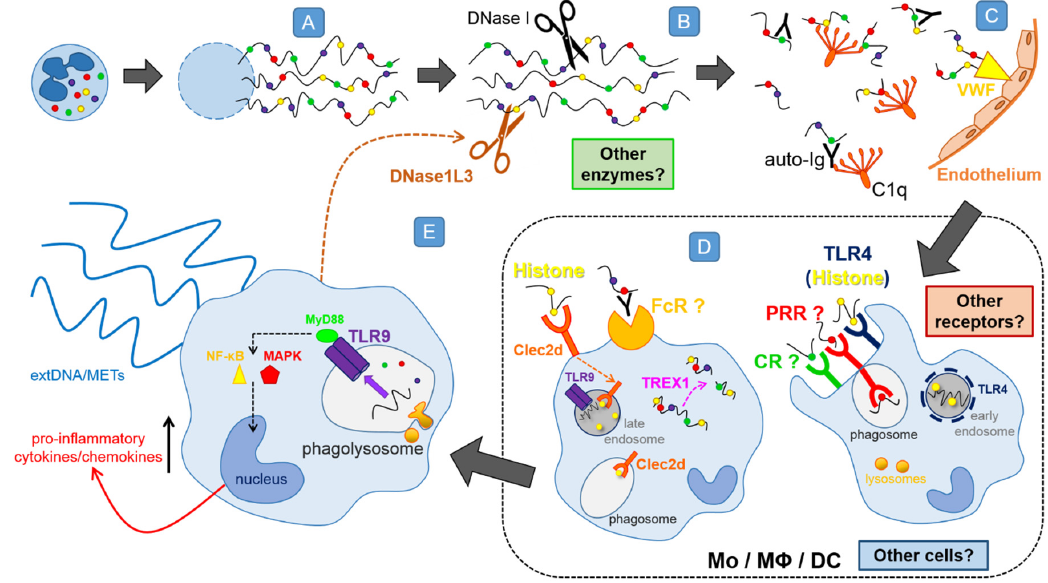
Figure 4. Hypothetical steps leading to the disassembly of NETs. ( A ) Once NETs are expelled into the extracellular space, ( B ) various DNA ‐ digesting enzymes, DNases (e.g., DNase1L3, DNase I) pre ‐ digest their backbone, composed of decondensed DNA, resulting in NET fragmentation ( B ), but the participation of other NET digesting enzymes operating extracellularly cannot be excluded. ( C ) Subsequently, NET proteins might be recognized by autoantibodies (auto ‐ Ig) to which C1q of the complement binds, but C1q can also directly attach to some NET components such as histones and DNA. Auto ‐ Ig and C1q might bind to NETs also, prior to the DNase action ( B ). What is more, ( C ) NETs can attach to the endothelium via the von Willebrand Factor (VWF), and remain present in the vasculature for a long time. ( D ) In the next step, phagocytes involved directly in NET removal, presumably recognize the NET components either with receptors for the Fc fragment of auto ‐ Ig or by other receptors present on the cells surface, such as pattern recognition receptors (PRR) or complement receptors (CR). Once internalized, NETs can be subjected to the action of intracellular DNA cleaving exonuclease TREX1 (DNase III). ( E ) Recognition by signaling receptors initiates cascades of events (including the MyD88 pathway) leading to pro ‐ inflammatory cytokine/chemokine production, as well as extrusion of strings of DNA by monocytes and macrophages, presumably in a form of monocyte/macrophage extracellular traps (METs). Clec2d—C ‐ type Lectin ‐ Receptor ‐ 2d, C1q—complement component 1q, CR—Complement Receptor, DNase—Deoxyribonuclease, DNase1L3—Deoxyribonuclease 1 Like 3 protein (DNase γ ), extDNA—extracellular DNA, FcR—Fc receptor, Ig—antibodies, MAPK—Mitogen ‐ Activated Protein Kinase, METs— monocyte/macrophages extracellular traps, MyD88—Myeloid Differentiation Primary Response 88, NF ‐κ B—Nuclear Factor Kappa ‐ light ‐ chain ‐ enhancer of Activated B cells, PRR—Pattern Recognition Receptor, TLR9—Toll-like receptor 9, TREX1—Three-prime Repair Exonuclease 1, VWF—Von Willebrand